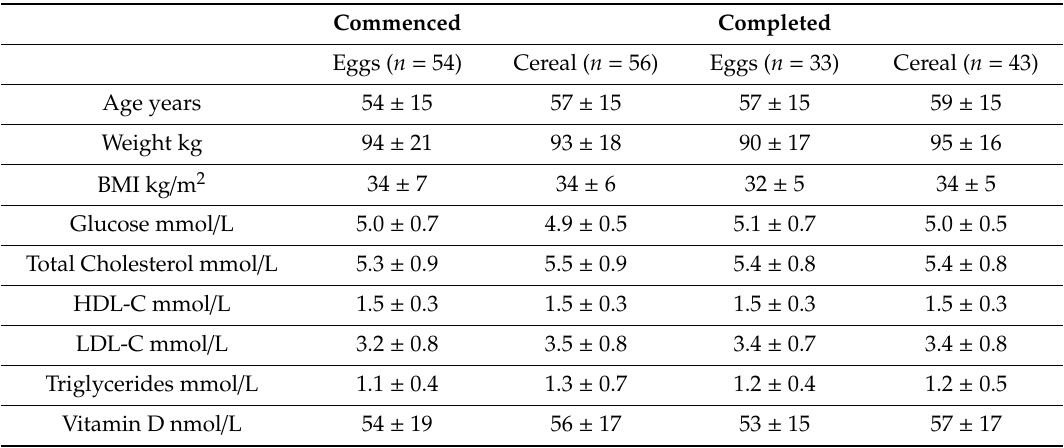
Table 1. Baseline characteristics of participants who commenced the study and baseline characteristics of participants who completed the study 1 .